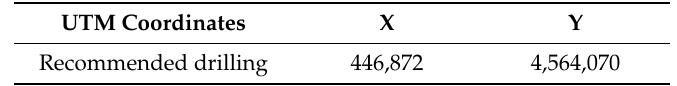
Figure 10. Location of the specific area and drilling recommended for the collection of groundwater. UTM coordinates of the recommended drilling (previously indicated in Figure 10) are included in Table 4. Table 4. UTM coordinates (time zone 30T) of the drilling suggested for the exploitation of possible geothermal resources.